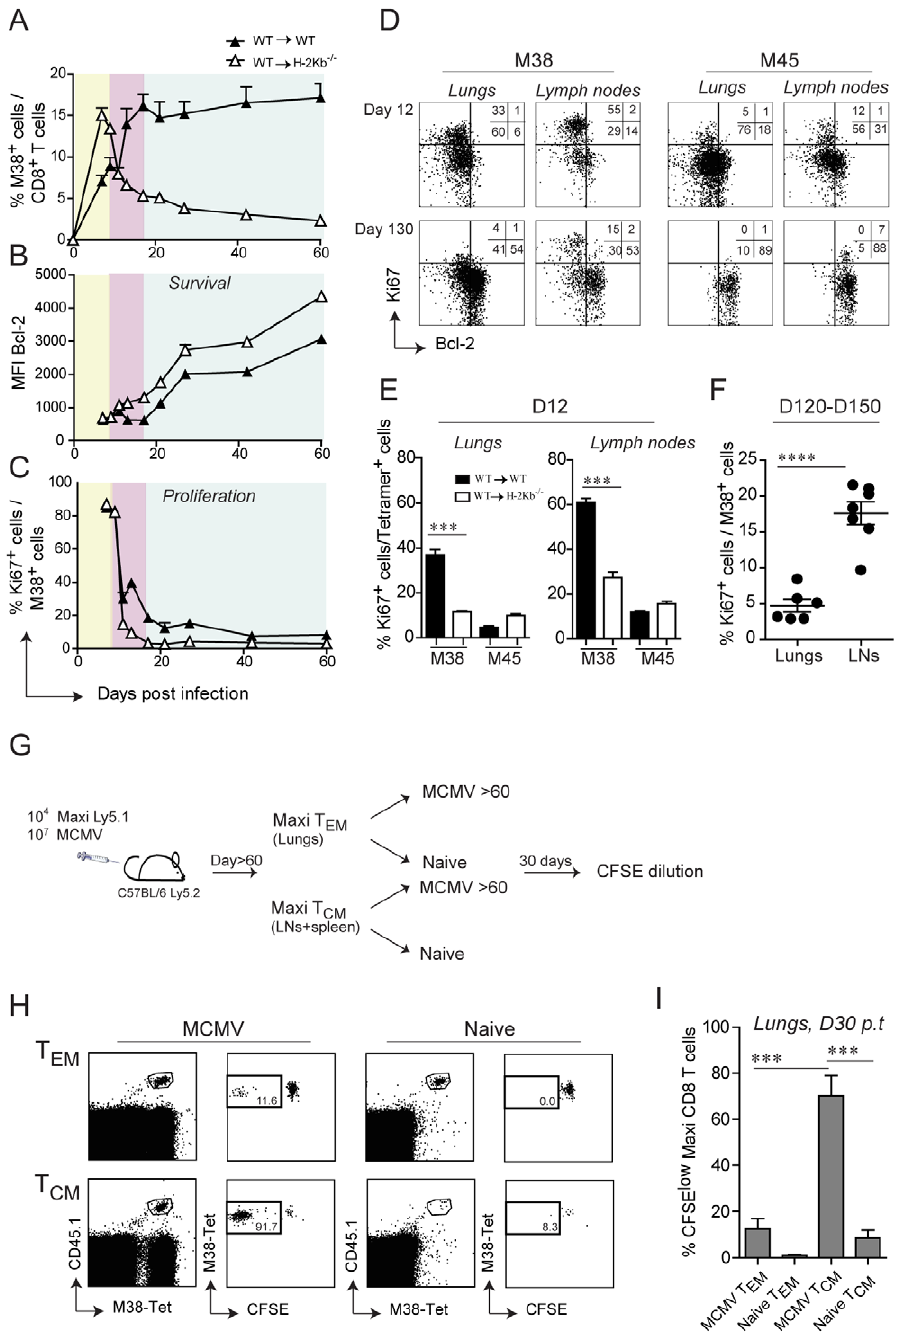
Figure 5. Non-hematopoietic cells promote extensive and systemic cell proliferation in the early phase of MCMV infection, but only local during latency. 10 5 Mini-CD8 T cells were transferred in WT R WT and WT R H-2K b 2 / 2 chimeric mice one day prior to infection with MCMV- D m157. (A) The percentage of M38-specific CD8 T cell response was measured in the blood on days 7, 9, 11, 13, 17, 21, 27, 42 and 60 post infection. Colors indicate different phases of the M38-specific response: primary expansion in yellow; secondary expansion in pink; maintenance phase in blue. Bcl-2 (B) and Ki67 (C) expression levels were measured on M38-specific CD8 T cells depicted in (A). One of two independent experiments is shown. (D) Representative FACS plots showing Bcl-2 and Ki67 expression on M38- and M45-specific CD8 T cells in the lungs and inguinal lymph nodes of WT R WT chimeric mice on day 12 post infection (upper panels) and day 130 post infection (lower panels). (E) The percentage of ki67 + cells in WT R WT and WT R H-2K b 2 / 2 chimeric mice is shown for M38- and M45-specific CD8 T cells in the lungs (left graph) and in the lymph nodes (right graph). One of three independent experiments is shown. (F) The percentage of M38-specific cells expressing Ki67 during latency is shown for the lungs and the lymph nodes. Data pooled from three independent experiments 6 SEM are shown. (G) Preferential antigen-driven proliferation of T CM M38-specific CD8 T cells during latency. Experimental layout: CD45.2 + C57BL/6 mice were adoptively transferred with CD45.1 + Maxi CD8 T cells and during latency T CM Maxi CD8 T were isolated from the LNs and the spleen, whereas T EM Maxi CD8 T cells were isolated from the lungs. Isolated cells were labeled with CFSE and transferred into naı¨ve or latently infected CD45.2 + C57BL/6 mice (Number of transferred cells: T CM =20 9 000/mouse,